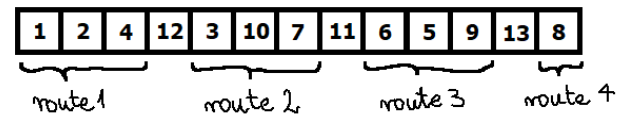
Figure 2. Example of a chromosome encoding one solution of